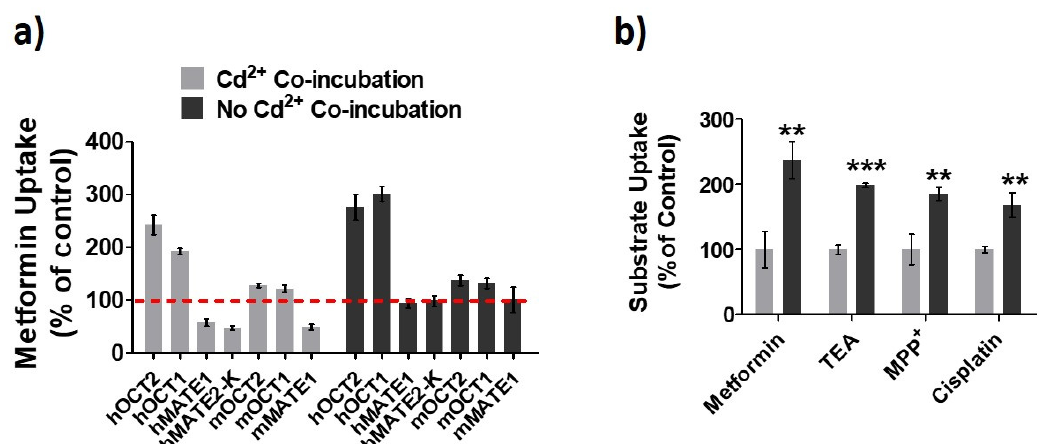
Figure 1. Effects of Cd 2+ exposure on the activities of organic cation transporters (OCTs) and multidrug and toxin extrusion proteins (MATEs). ( a ) Cellular uptake of metformin in HEK293 cells stably expressing human (h) OCT1, hOCT2, hMATE1, and hMATE2-K; transiently expressing mouse (m) OCT1, mOCT2, and mMATE1 after pre-incubation Cd 2+ for 20 min. Then, uptake of metformin was performed with (Cd 2+ Co-incubation) and without Cd 2+ (No Cd 2+ Co-incubation). Uptake without Cd 2+ during both pre-incubation and co-inhibition served as the control. Uptake values are shown as the percentage of control. ( b ) Cellular uptake of metformin, TEA, MPP + and cisplatin in HEK-hOCT2 cells with (dark gray) and without (light gray) Cd 2+ pre-incubation for 20 min. Data are presented as mean ± S.D.; ** p < 0.01, *** p <